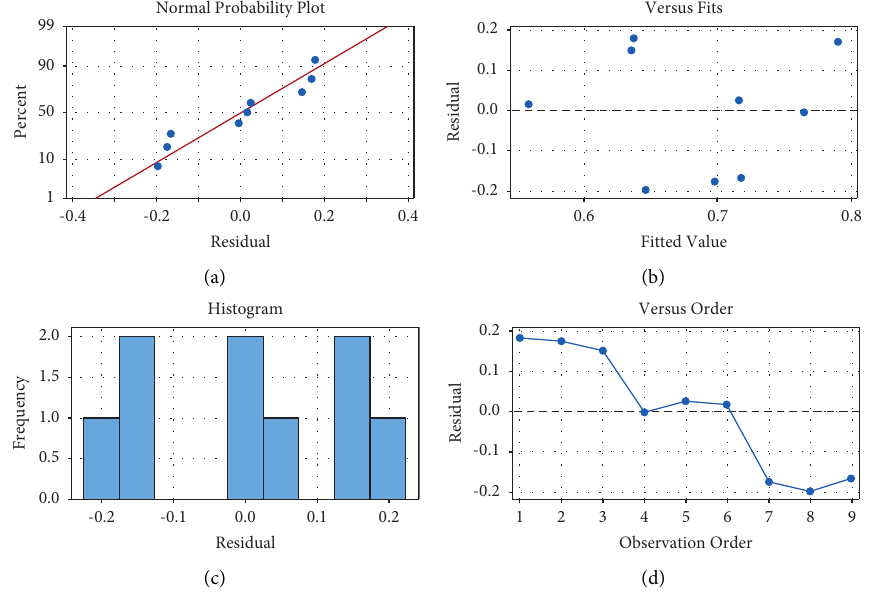
Figure 18: Residual plot analysis for milling AA 2014 material.